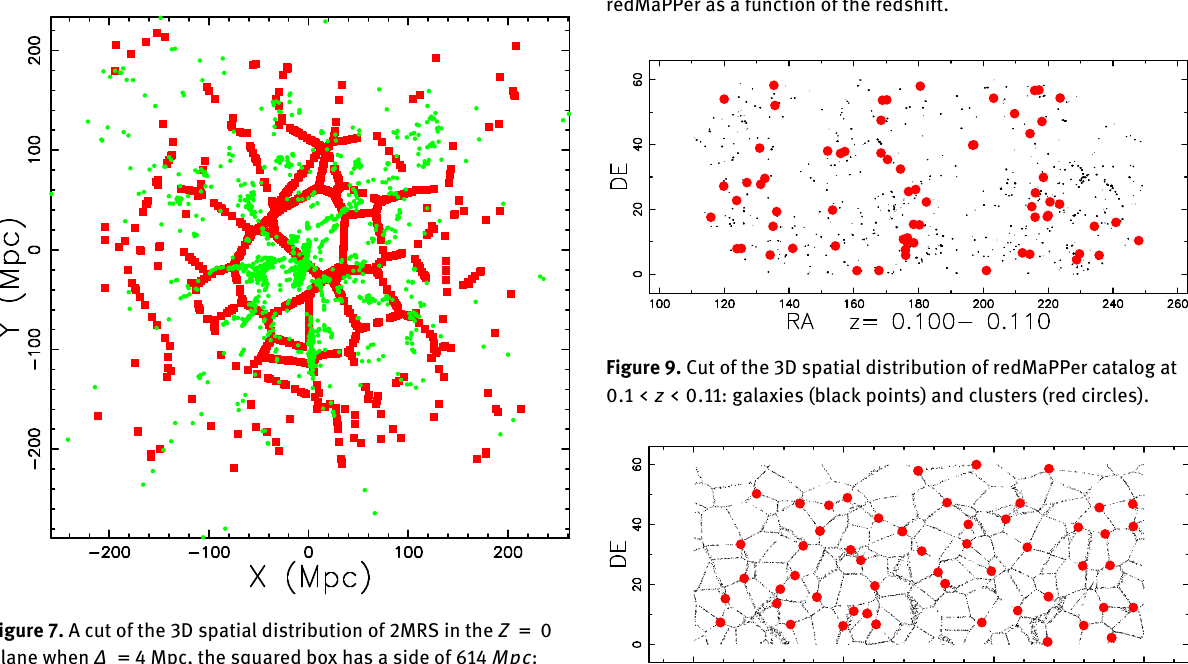
Figure 7. A cut of the 3D spatial distribution of 2MRS in the Z = 0 plane when ∆ = 4 Mpc, the squared box has a side of 614 Mpc : we have 1384 galaxies (green filled circles). The same number of V P (2, 3) (red squares) with radial scaling as the number of real galaxies with the same parameters as in Table 2.